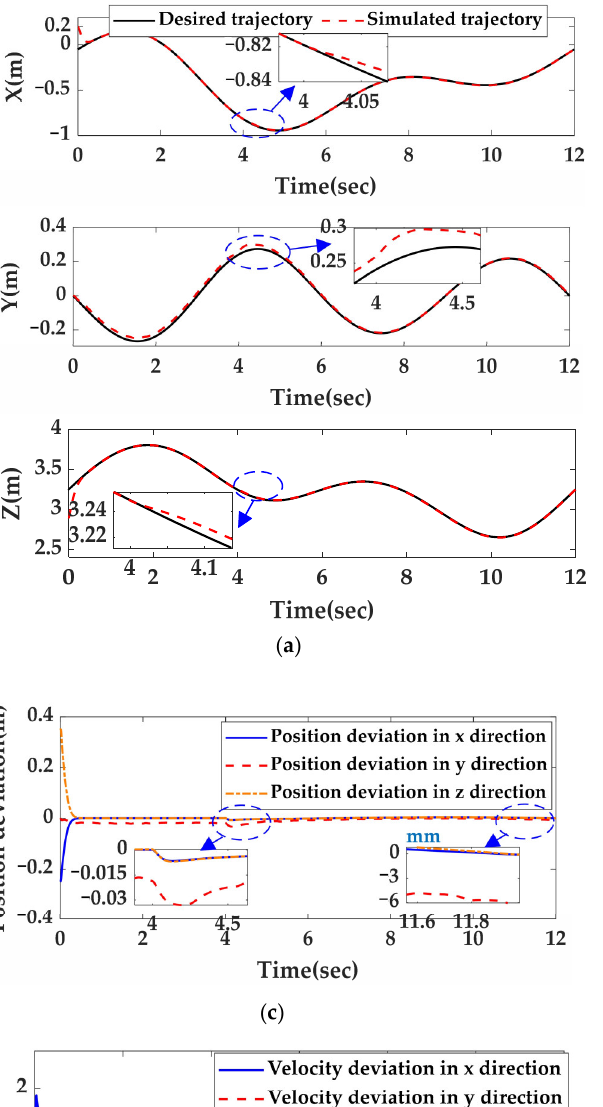
( b ) Figure 11. Trend of controller parameters: ( a ) adaptation of parameters; ( b ) sliding surfaces versus time with external disturbance. The force and torque output results are shown in Figure 12. It can be clearly seen from Figure 12a that the cable tension value before optimization appears negative, which is completely inconsistent with the actual situation and needs to be optimized through the tension optimization algorithm. The optimized cable tension changes smoothly and continuously within the set upper and lower limits. It can be seen from Figure 12c that the trend of the motor torque is basically consistent with the optimized cable tension value.